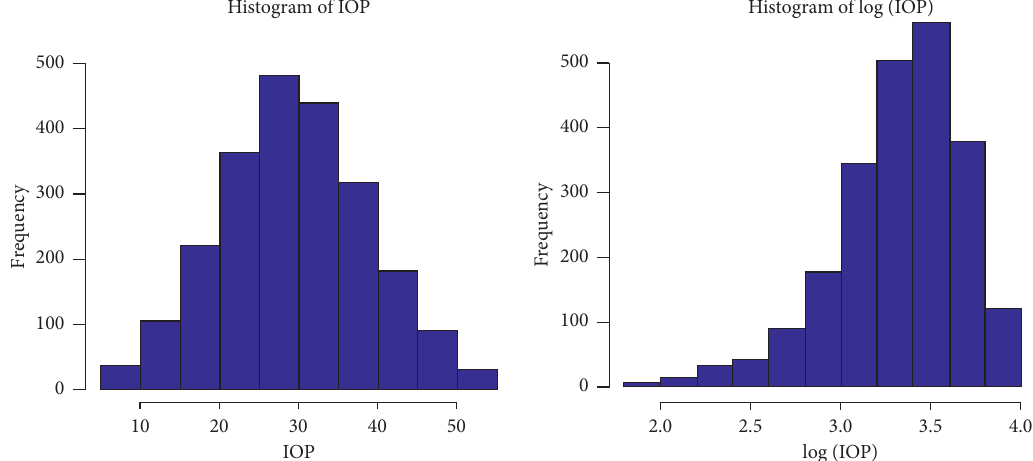
Figure 2: Histogram of original IOP (a) and log of IOP (b) for glaucoma patients.